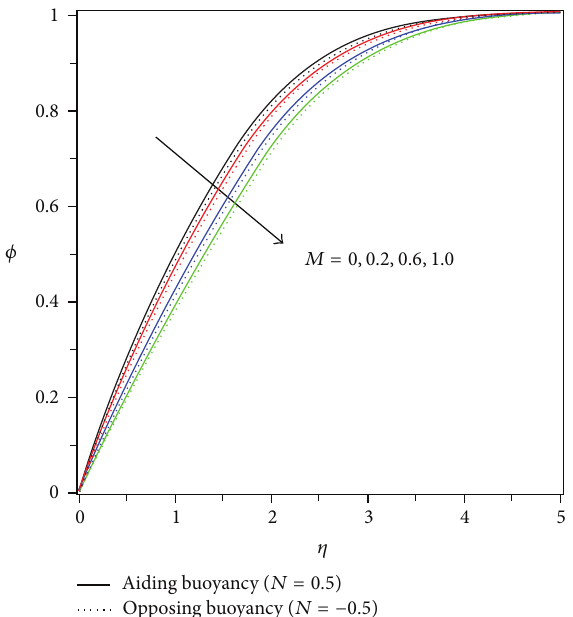
Figure 7: Concentration profile for both aiding and opposing buoyancy for different values of 𝑀, Df = 0.02 , Sr = 0.2 , Gr = 0.1 , and Le = 1.0